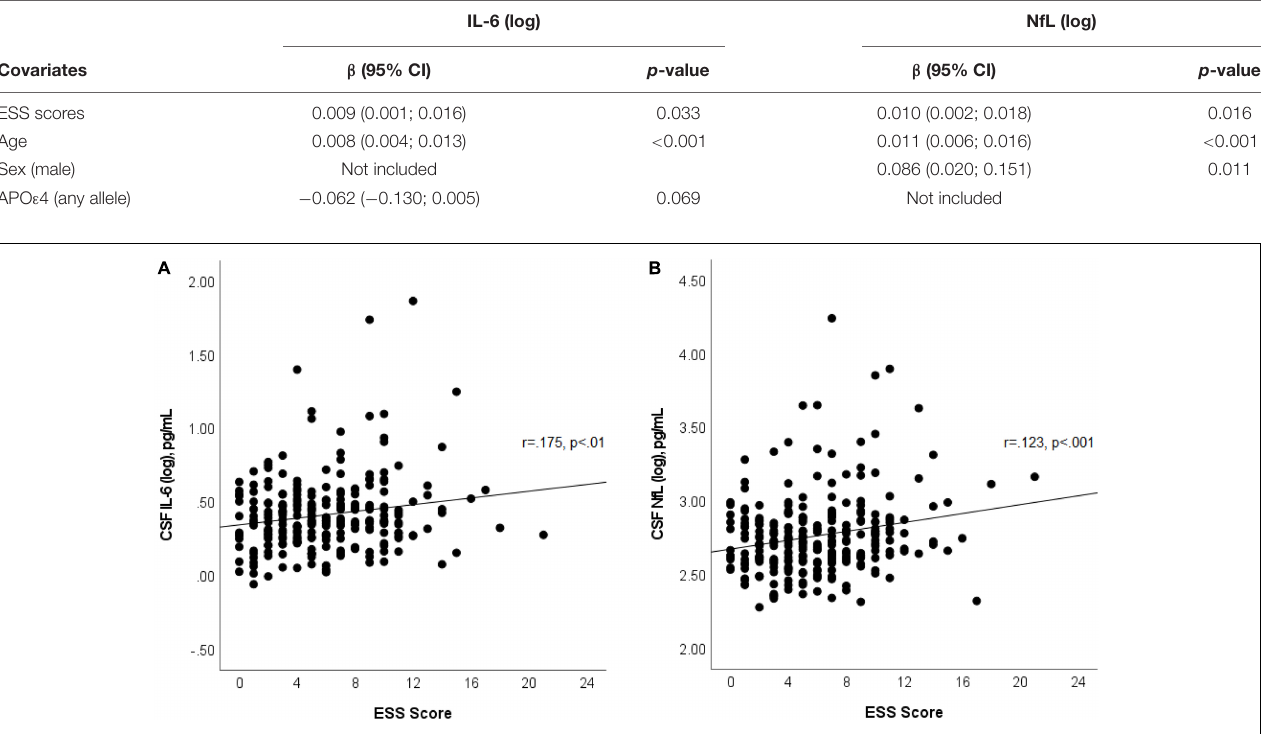
FIGURE 1 | Scatterplot shows associations between ESS scores and log of CSF IL-6 (A) and log of NfL (B) . Best fit line is displayed, with the Pearson correlation coefficient and its p -value.